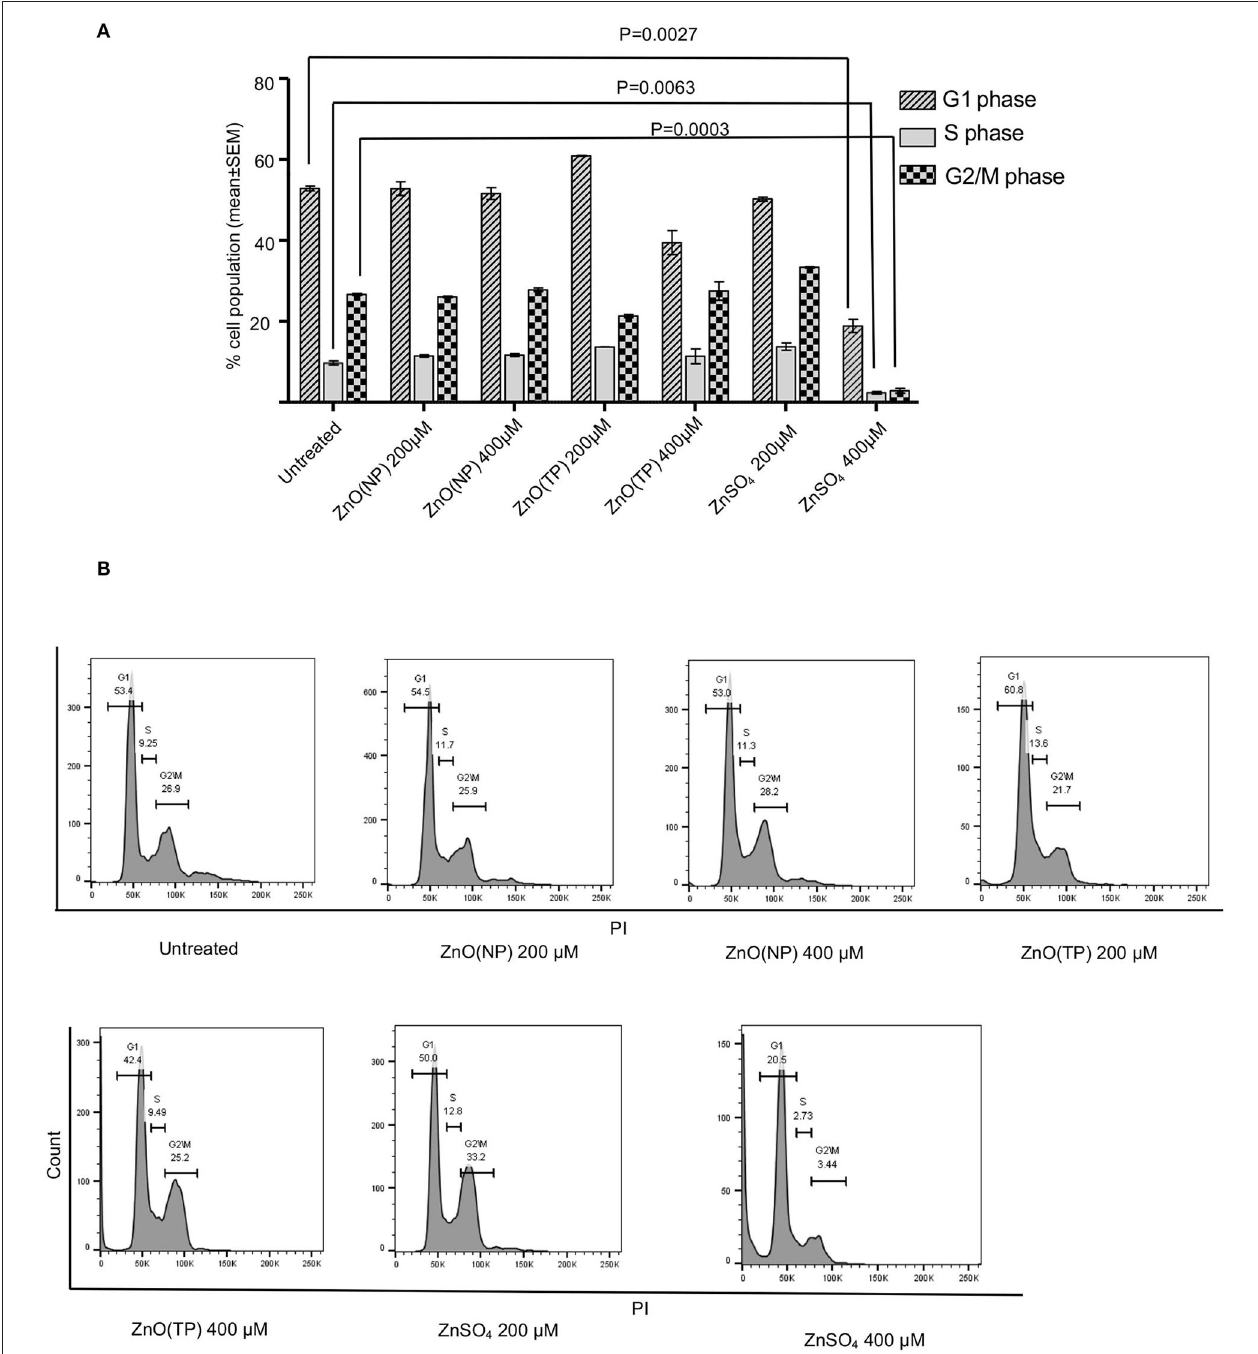
FIGURE 3 | Cell cycle progression analysis after Zinc compound treatment. (A) Percentage cell population in G1, S, and G2/M phases of Huh7 cells after 24h treatment with indicated concentration of ZnO(NP), ZnO(TP), and ZnSO 4 . (B) The representative histograms from FACS analysis of percentage of cell population in G1, S, and G2/M phases of Huh7 cells. Values are represented as mean ± SEM of three independent experiments. treated Huh7 cells. ROS was detected using the H 2 DCFDA (2 dichlorofluorescin diacetate) fluorescence dye. Huh7 cells were treated with 100, 200, and 400 µ M of ZnO(NP), ZnO(TP), and ZnSO 4 , respectively, for 6 h, followed by the measurement of